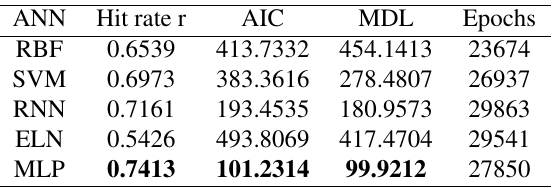
Table 6. Stage 1. Results with AIC and MDL criteria (20 runs)